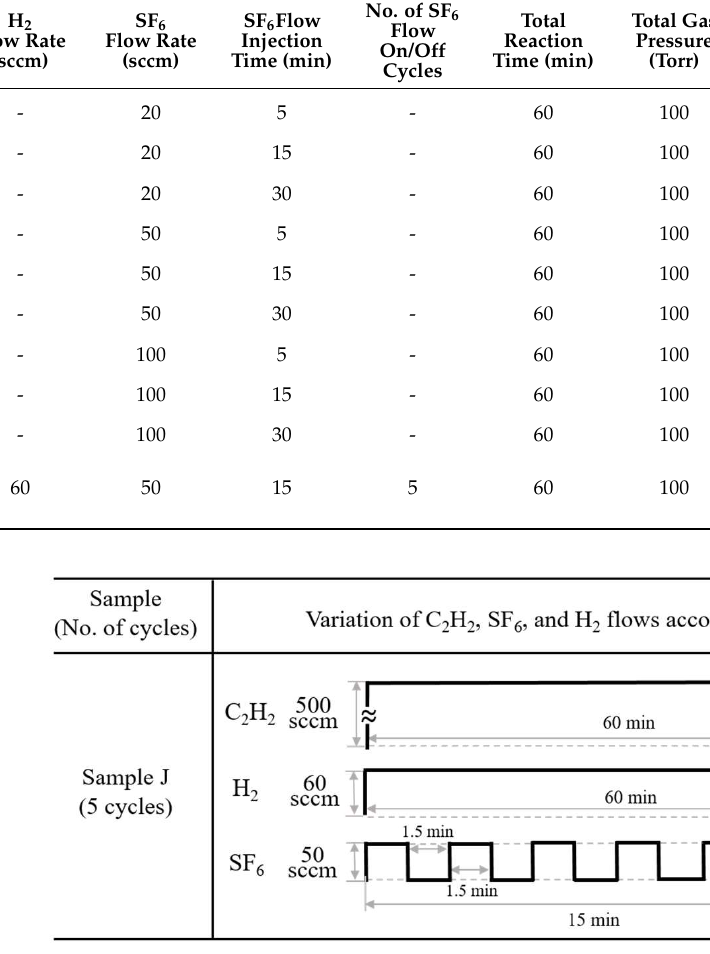
Figure 9. Cyclic injection processes of C 2 H 2 , H 2 , and SF 6 flows for sample J.